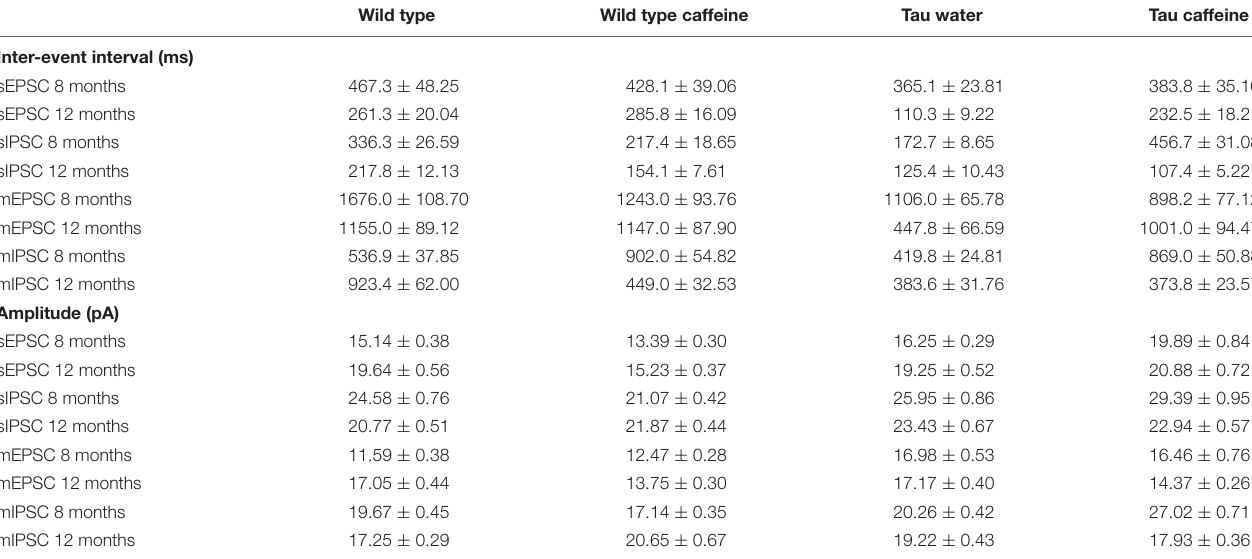
TABLE 1 | Characteristics (inter-event intervals and amplitudes) of spontaneous and miniature glutamatergic and GABAergic currents recorded in vitro in CA1 pyramidal cells in 8 and 12 month-old Wild type and Tau mice exposed or not to caffeine during early